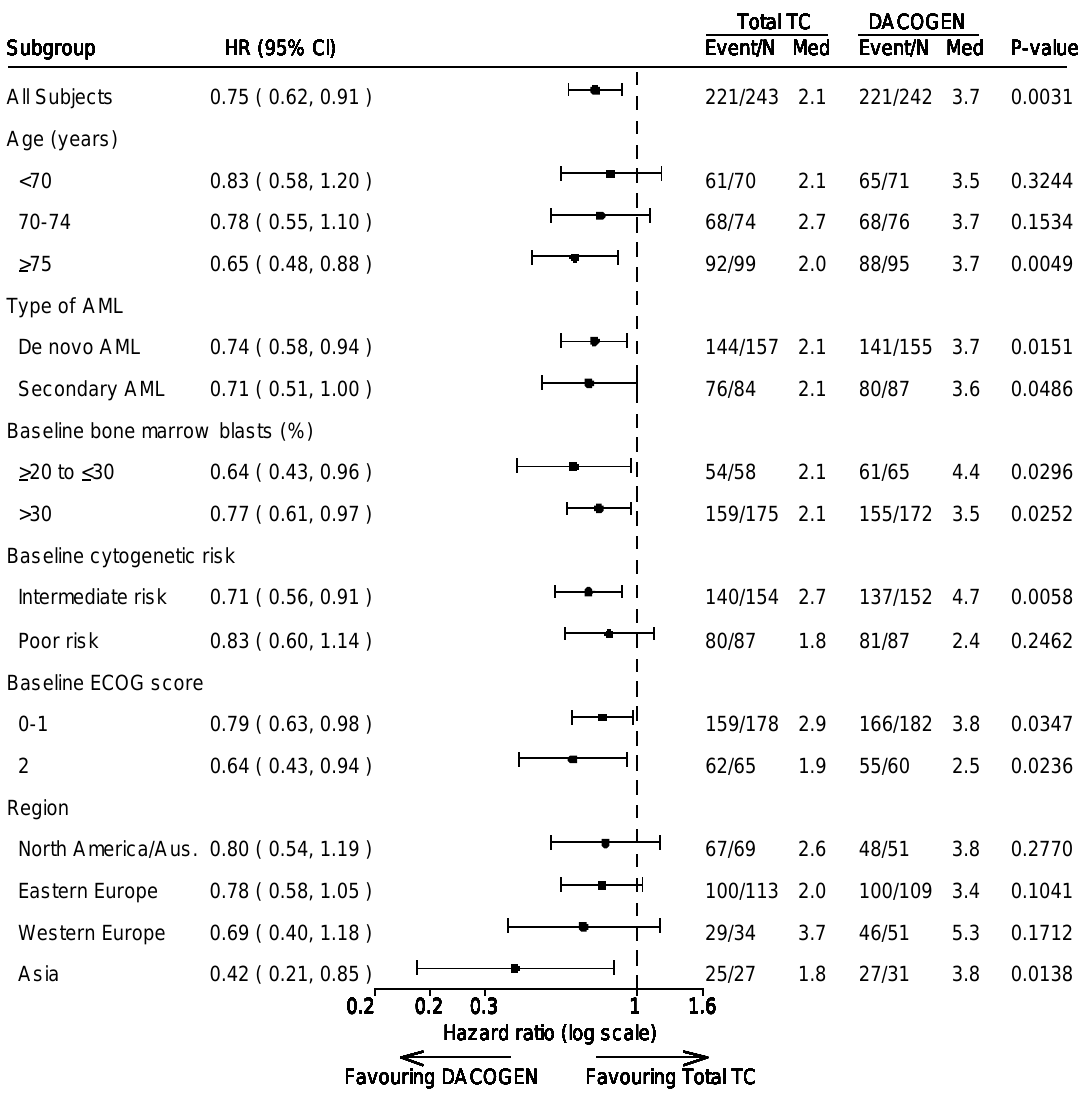
Figure 6: Progression-Free Survival Subgroup Analysis (Study DACO-016) (Intent to Treat Analysis